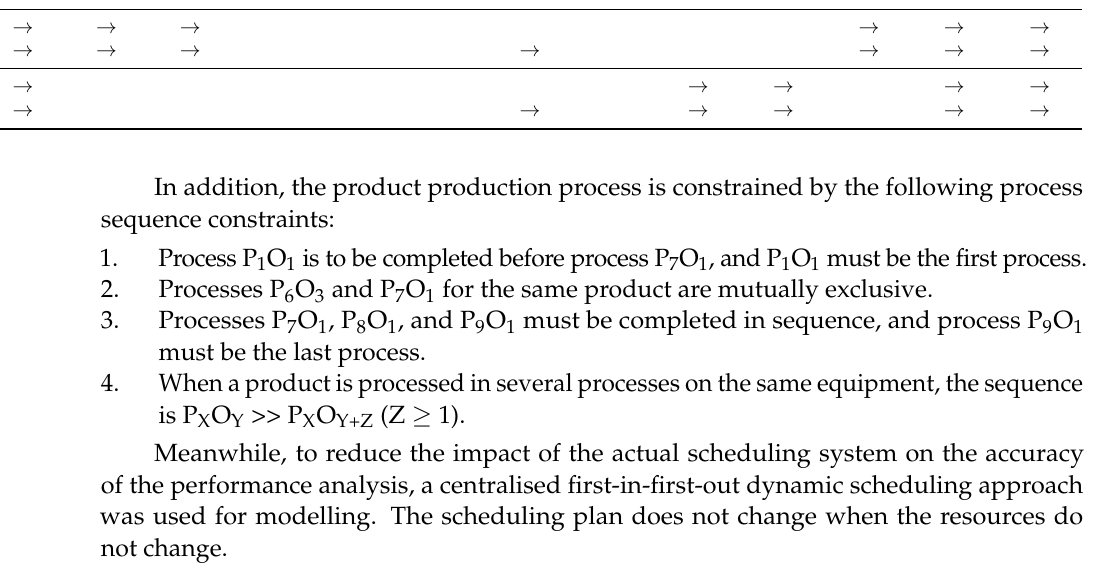
Table 1. Schematic of process planning for products .